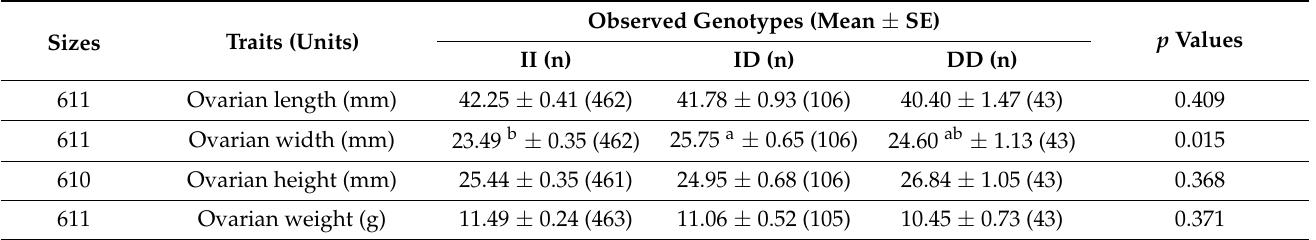
Table 3. Relationships between P1-D 13-bp polymorphisms of ITG β 5 and ovarian morphological traits.